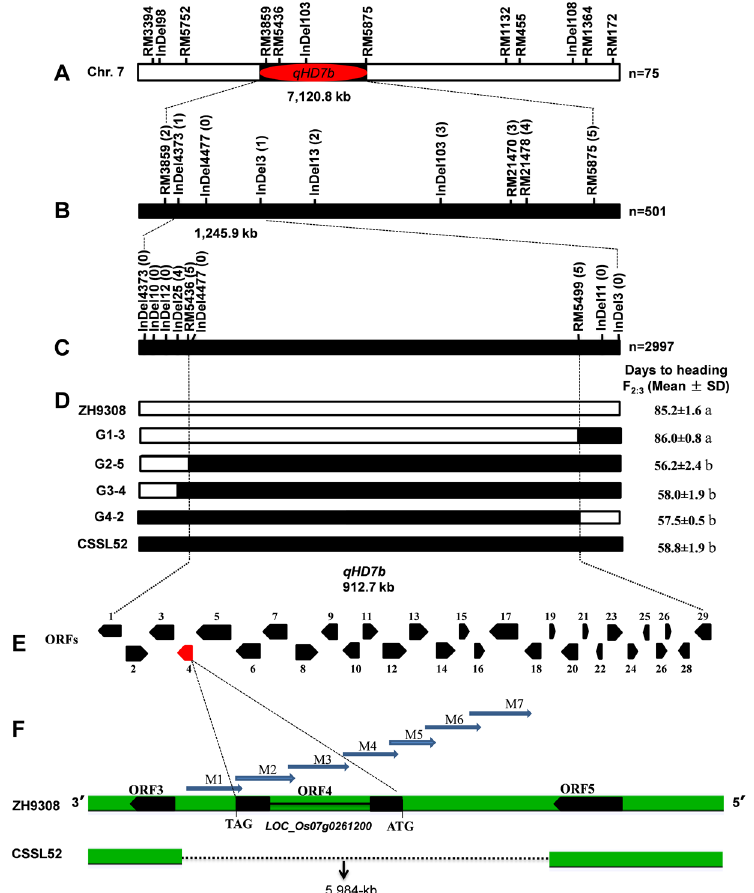
Figure 3. Coarse mapping and fine mapping of qHD7b on chromosome 7. ( A ) The position of qHD7b based on 76 CSSLs genotyped with 12 molecular markers on chromosome 7. ( B ) The position of qHD7b based on 501 BC 5 F 2 plants genotyped with 7 markers located between RM3859 and RM5875 (the flanking markers identified using the CSSLs). ( C ) Fine mapping of qHD7b using BC 5 F 2:3 plants genotyped with 7 markers that mapped between InDel4373 and InDel3 (the flanking markers identified using the 501 BC 5 F 2 plants). ( D ) Genotypes and phenotypes of the two parents (ZH9308 and CSSL52) and 14 homozygous recombinant lines used for fine mapping of qHD7b . The ZH9308 and CSSL52 genotypic markers are represented by white and black bars, respectively. The 14 homozygous recombinants belong to four groups (G1 = 3 plants, G2 = 5 plants, G3 = 4 plants, and G4 = 2 plants). The superscripted letters (a and b) indicate statistically significant differences in the heading dates of recombinants relative to the parents. ( E ) Approximately 29 open reading frames (ORFs) were located between the two flanking markers identified during the fine mapping (RM5436 and RM5499), which are summarized in Table S4. ( F ) Sequence comparison between ZH9308 and CSSL52 with 5.984-kb deletion in CSSL52 at Os07g0261200 using 7 markers (M1 to M7). The deleted region in CSSL52 is significant, and seven molecular markers ( Ghd7 -M1 to Ghd7 -M7) linked with qHD7b are amplified in